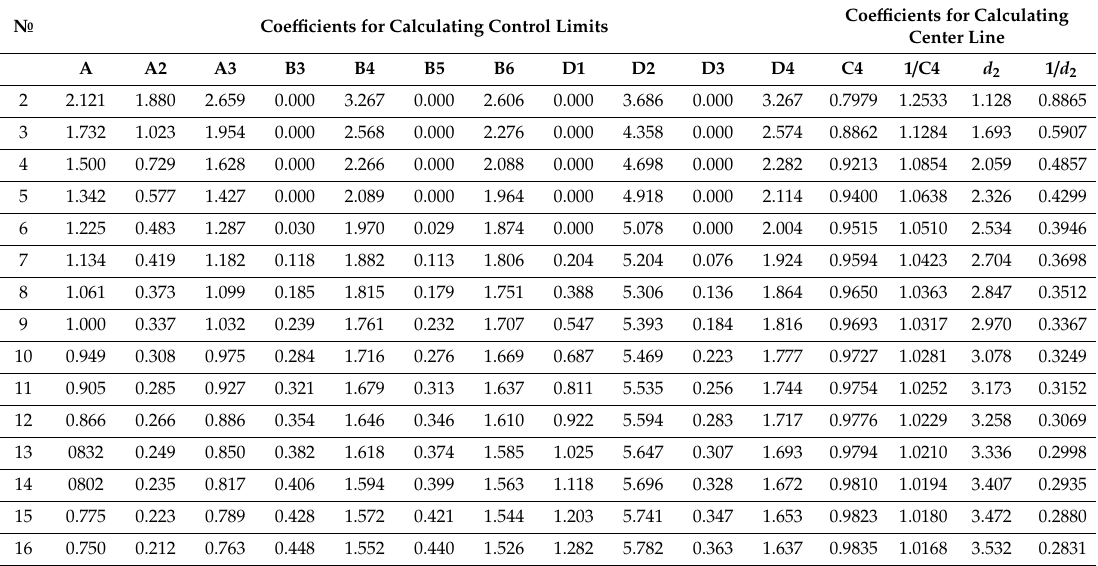
Table 2. Coe ffi cients for the calculation of control chart lines (author’s